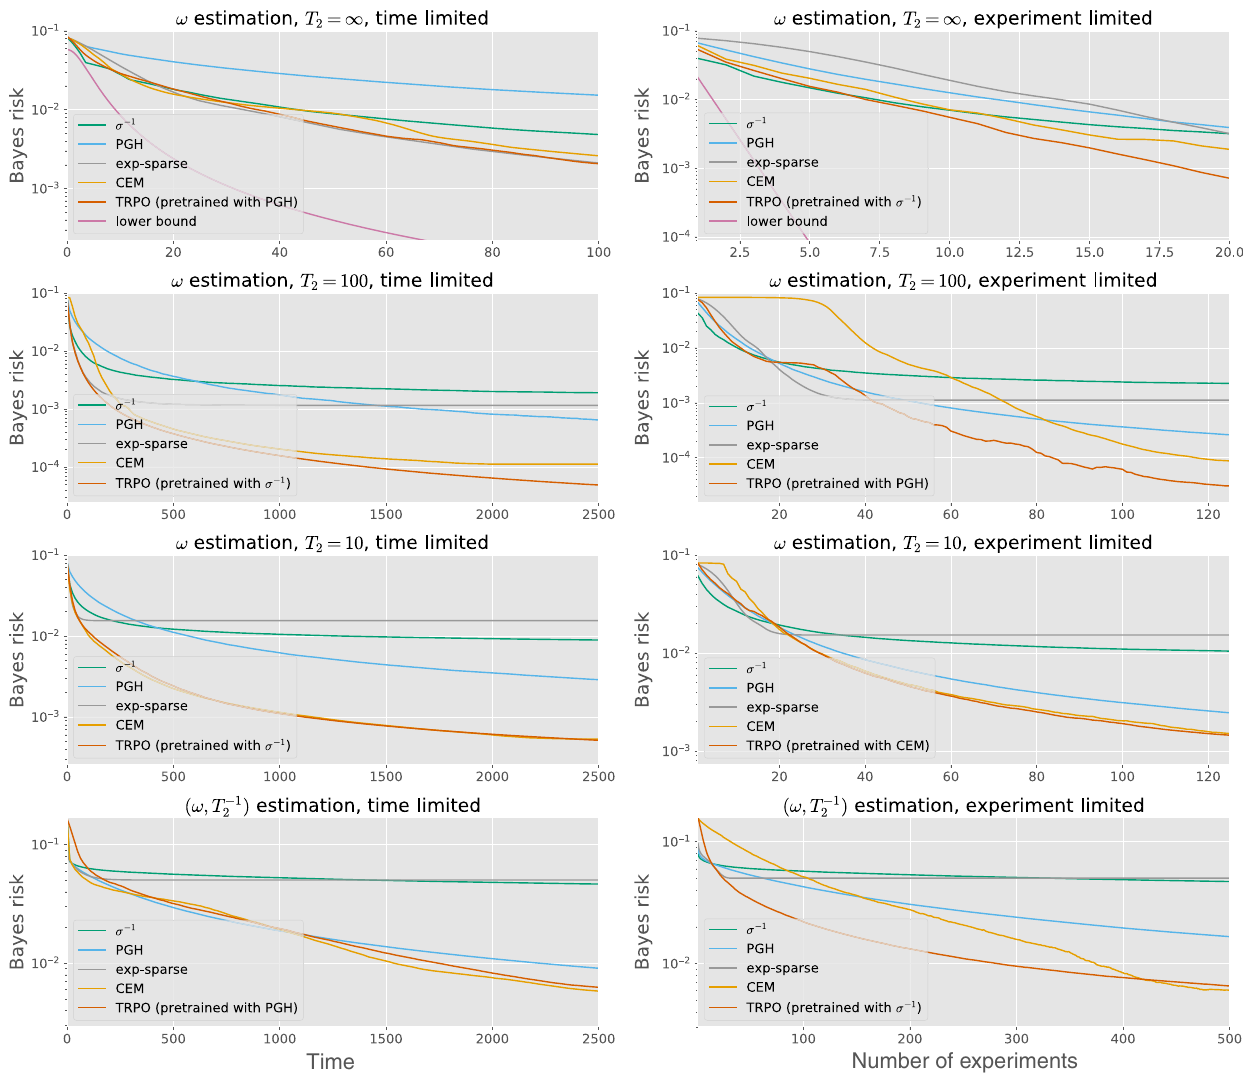
FIG. 2. Comparison of the Bayes risk for different experiment-design heuristics. The right column shows Bayesian estimation with a limited number of experiments and the left column shows Bayesian estimation with a limit on the available time (limited to the maximal value plotted on the x axis). We study frequency estimation without T 2 relaxation (top row) and with T 2 relaxation (second and third rows, with different values of T 2 as stated in the plot titles) as well as the simultaneous estimation of the frequency ω and (bottom row). The Bayes risk is calculated numerically from 10 4 episodes; see Appendix B for details. TRPO is relaxation rate T − 1 2 pretrained with the heuristic specified in parentheses. The lines are linear interpolants to guide the